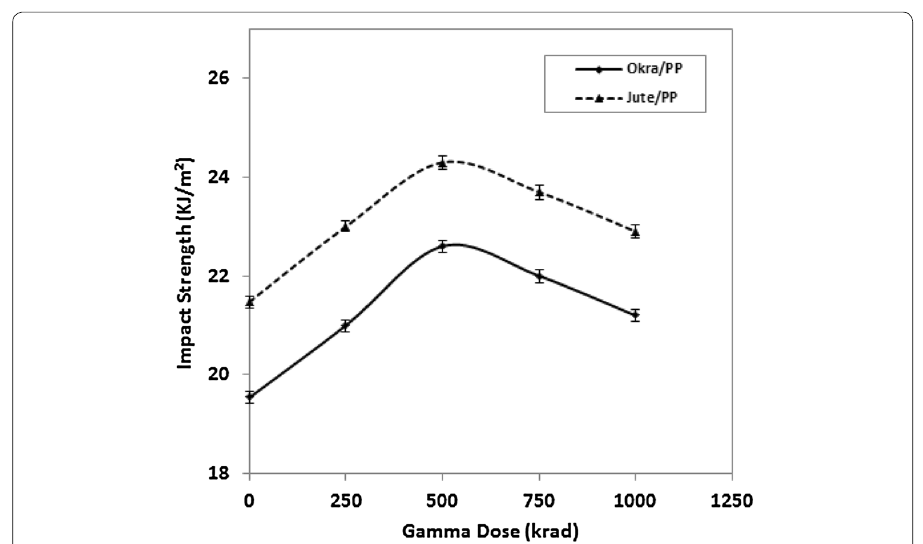
Fig. 6 Comparative Charpy impact strength of irradiated composites against radiation